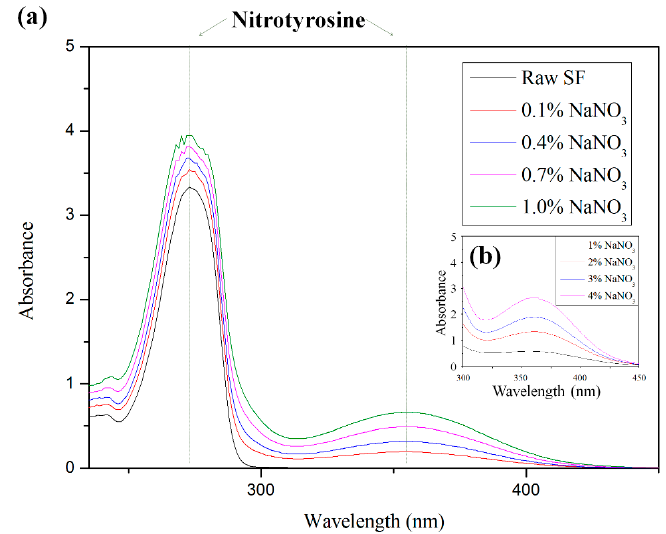
Figure 7. UV-vis spectroscopy results of SF gels depending on the NaNO 3 concentration: ( a ) 0% to 1% NaNO 3 and ( b ) 1% to 4% NaNO 3 .